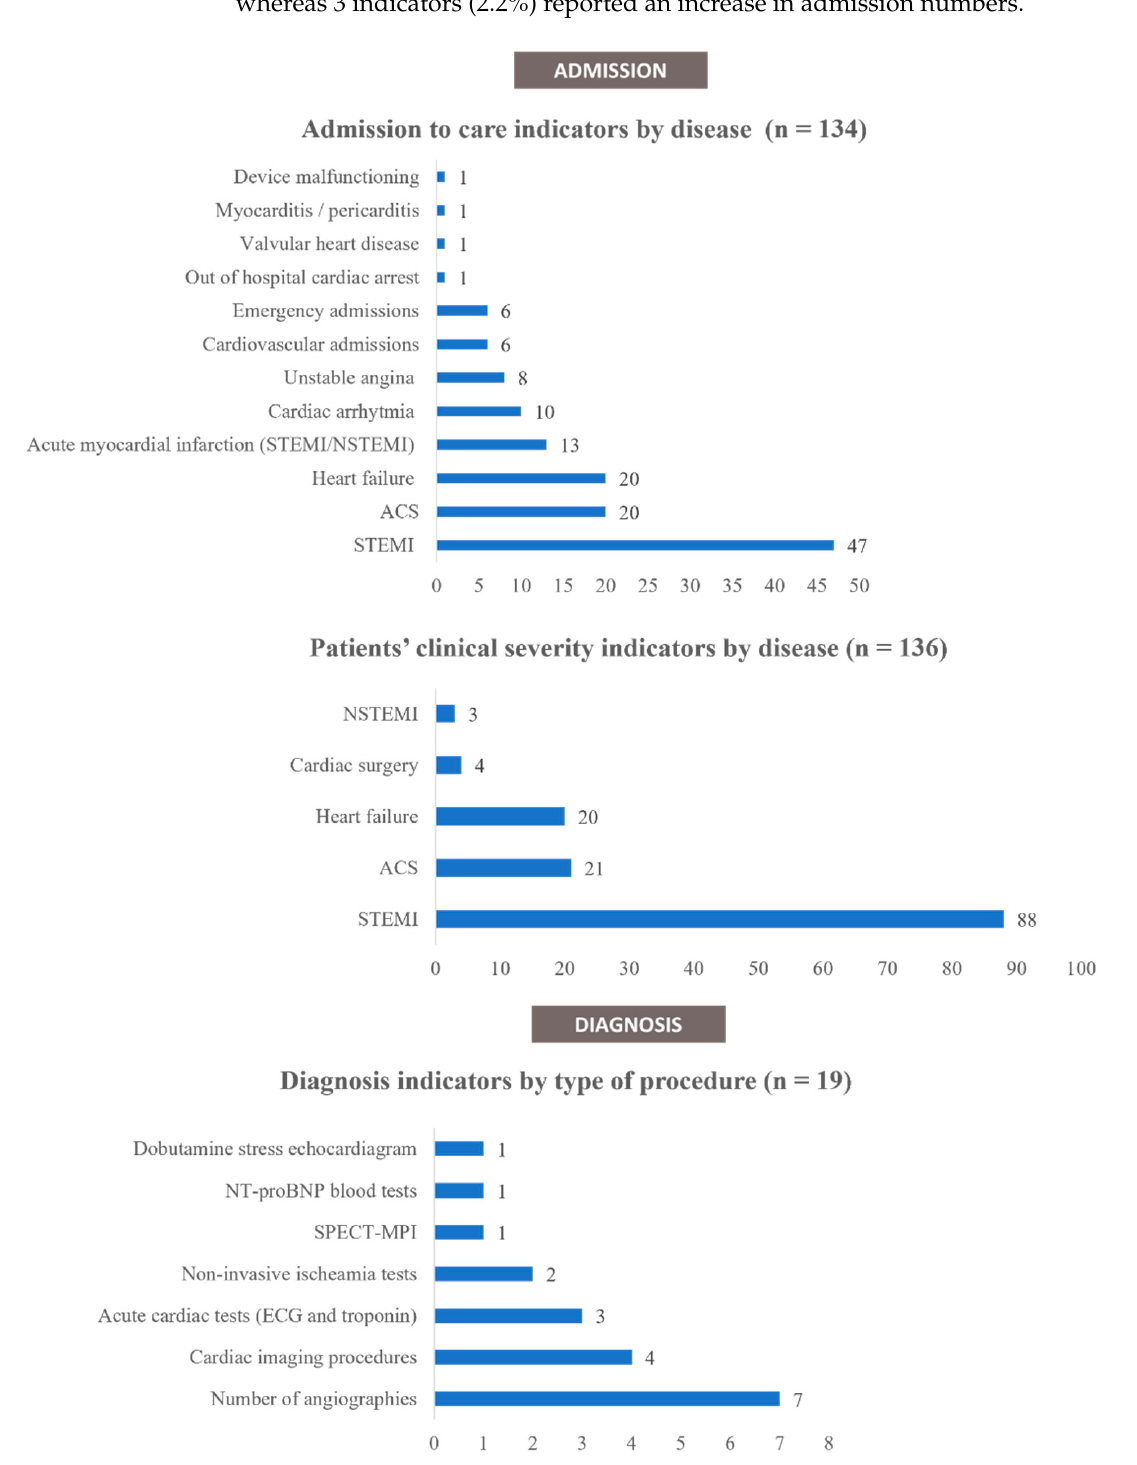
Figure 4. Admission and diagnosis indicators by disease. Abbreviations: ACS—Acute coronary syn- dromes; NSTEMI—Non-ST-elevation myocardial infarctions; SPECT-MPI—Single-photon emission computed tomography myocardial perfusion imaging; STEMI—ST-elevated myocardial infarc- tions.